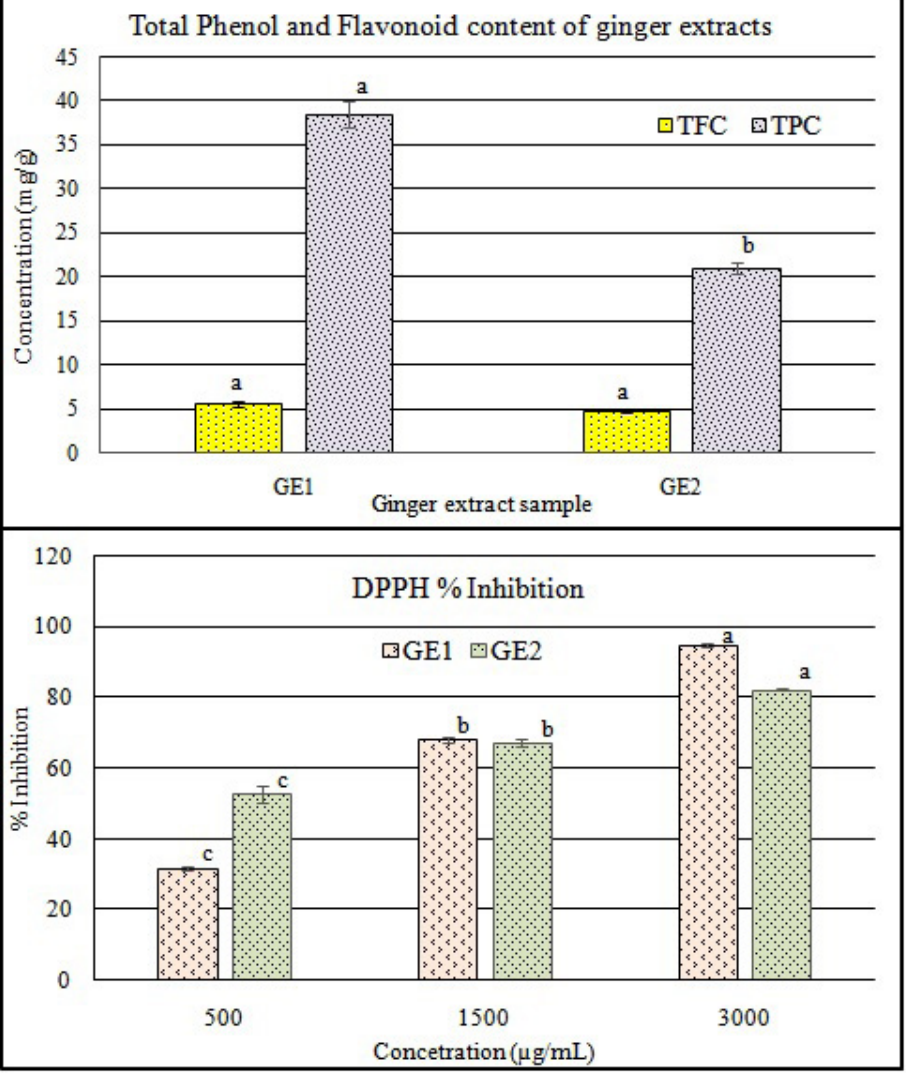
(GE2) method. Different letters on 2